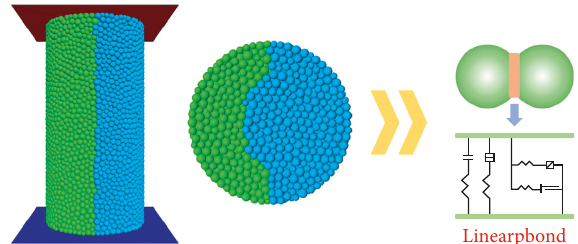
Figure 7: Simulated specimen and bonding model.